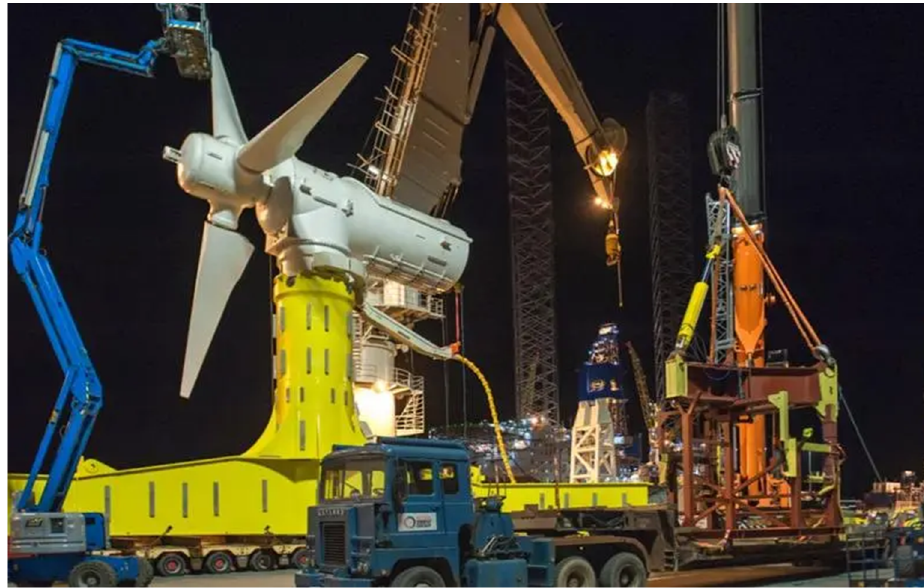
Figure 2. Atlantis AR1500 turbine